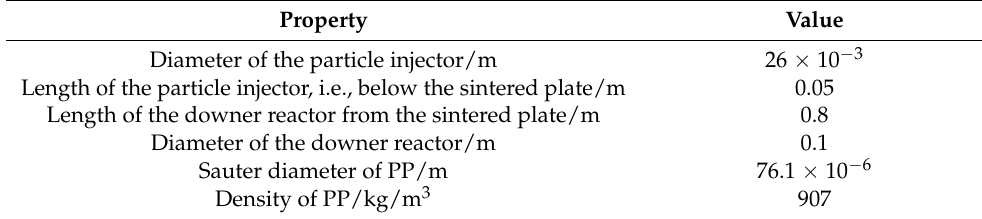
Table 1. Configuration parameters to investigate the particle residence time distribution.